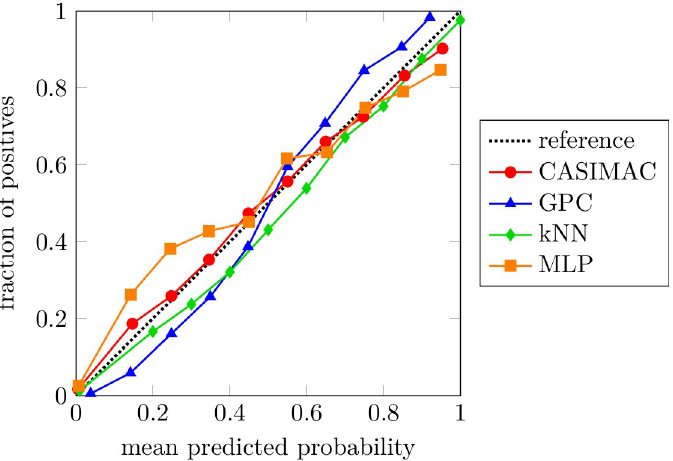
Fig 8. Calibration curves. Calibration curves for the benchmarked classifiers on the pine data set. The closer the curves are to the diagonal reference line, the better the calibration of the respective classifier. In particular, our method exhibits the best calibration properties.